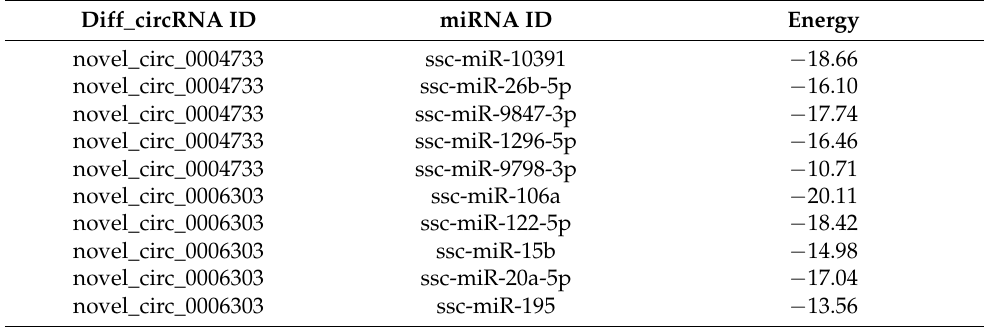
Table 2. Target gene prediction of partial differential lncRNAs (co-location).